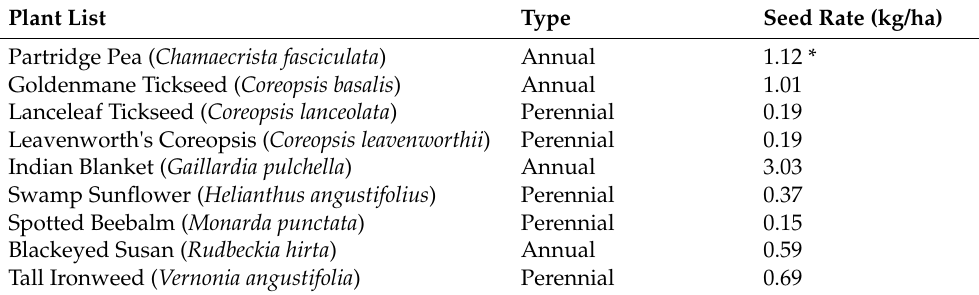
Figure 1. Map depicting locations of the eight sites that included a 0.1 ha wildflower plot and a fallow control plot (the latter a minimum of 500 m away from the wildflower plot). The listed coordinates for each site fall between the wildflower plot and the fallow control plot at the given site. All sites were a minimum of 3 km apart. Table 1. List of native wildflowers and seed rates used to establish the wildflower plots for this study. * Partridge pea was planted separately, i.e., in its own strip that occupied ~15% of the wildflower plot. The seeds were purchased from Wildflower Seed and Plant Growers Association (Crescent City, Florida).